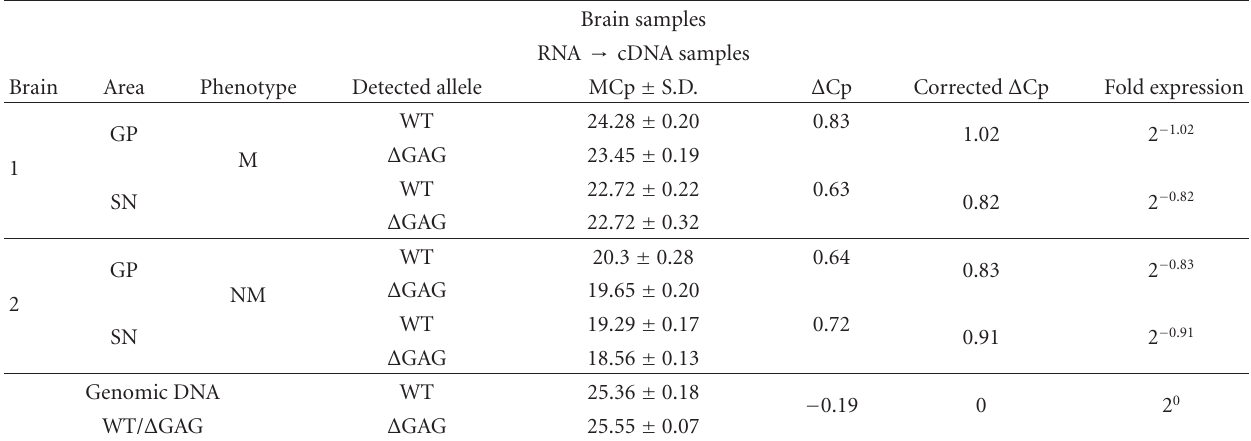
Table 3: Expression ratio of WT to Δ GAG TOR1A in brains from MC and NMC. Brain samples RNA → cDNA